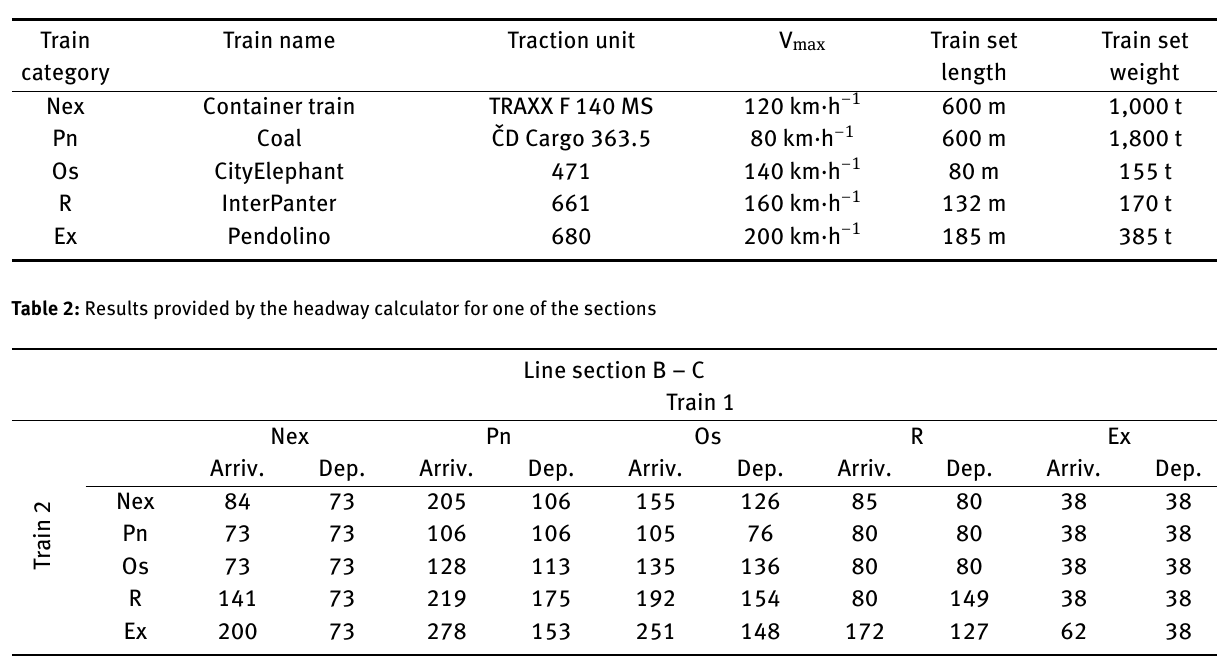
Table 1: Parameters of type train sets used Train